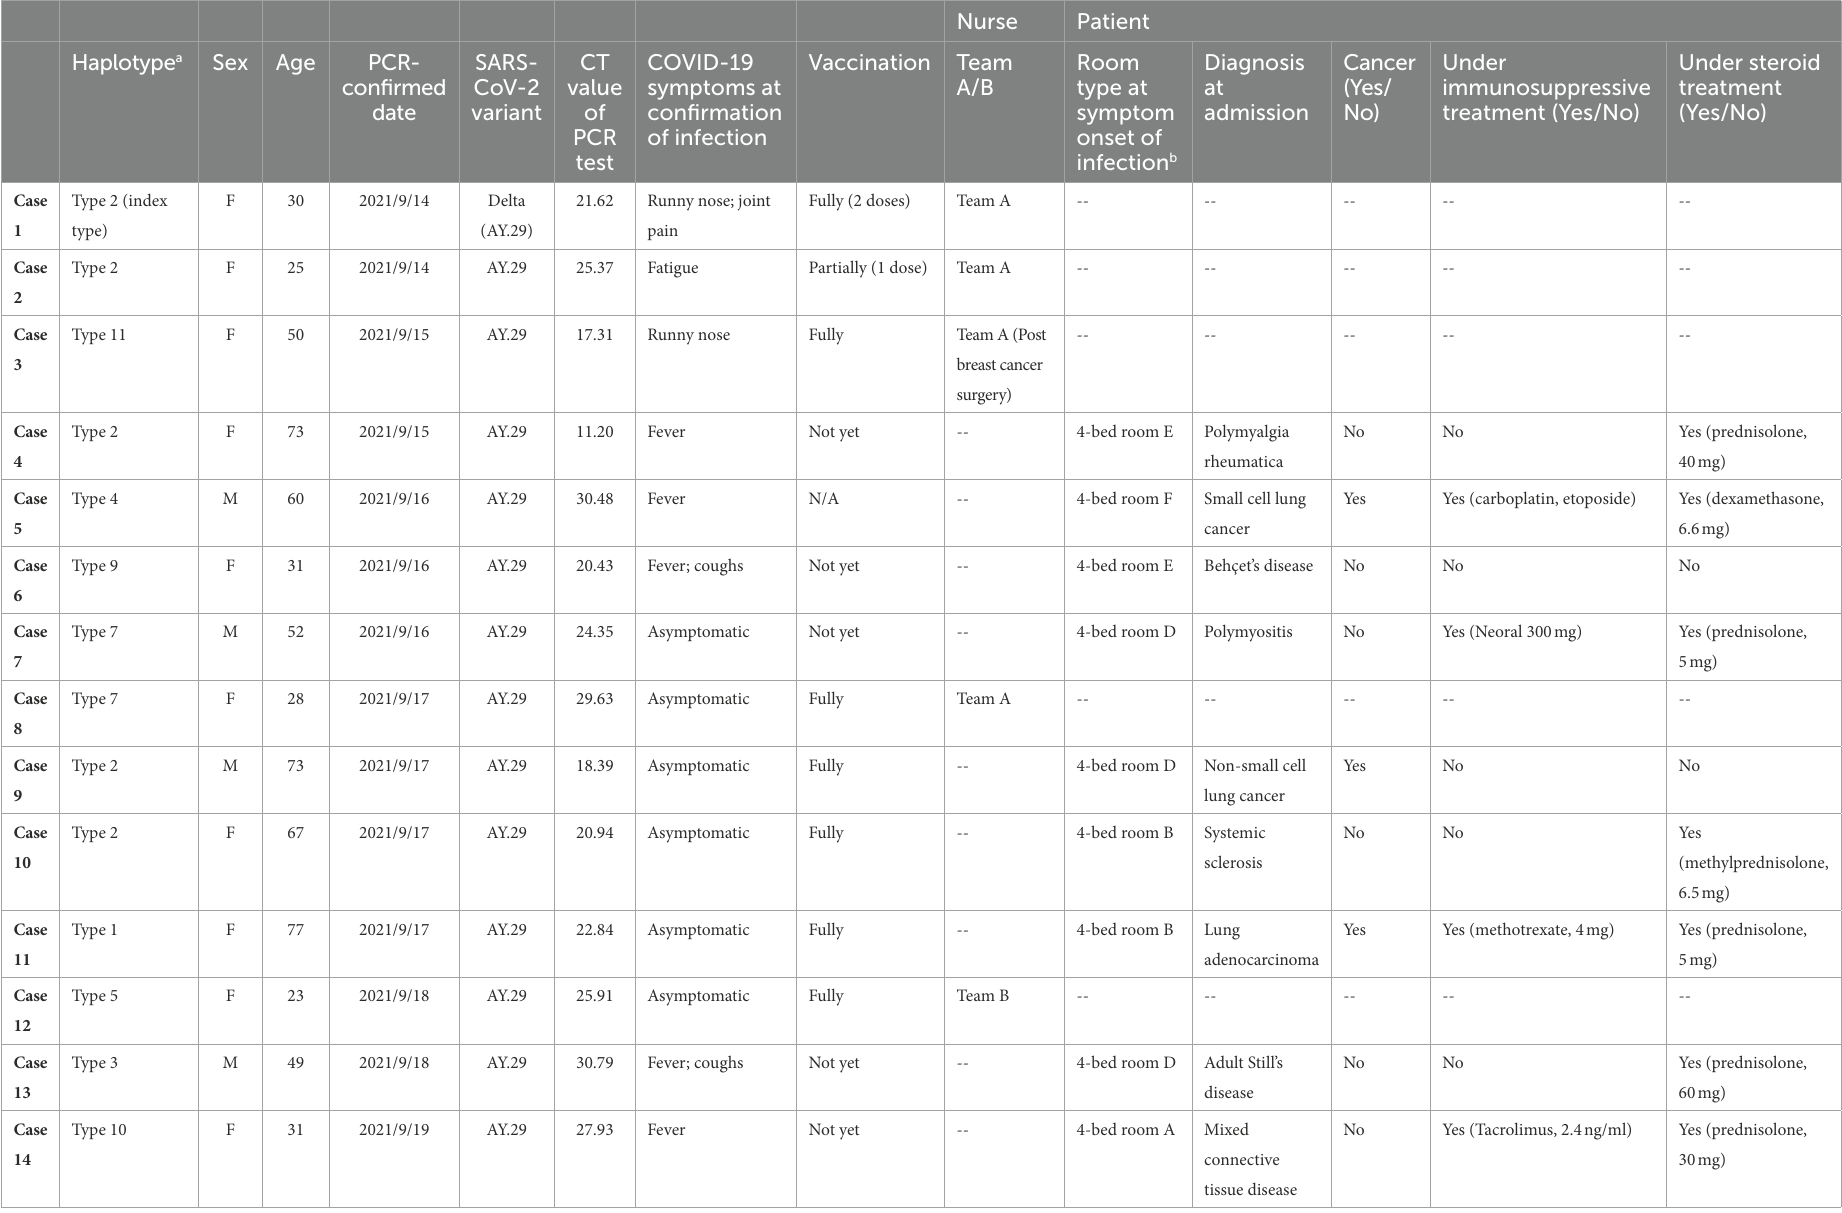
TABLE 1 Characteristics of infected nurses and patients in the nosocomial cluster, September 14 through September 28,